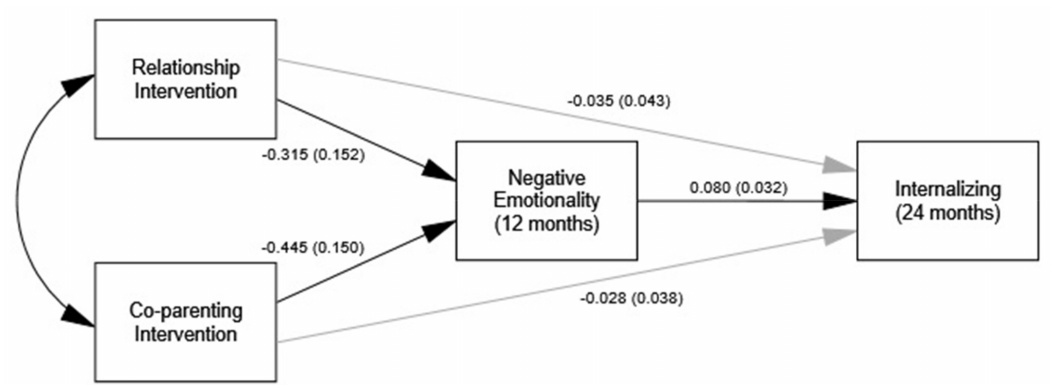
Figure 2. Model estimates (SE) for e ff ects of intervention on reduced externalizing symptoms at 12-months and reduced infant externalizing symptoms at 24-months. Single-headed black arrows represent significant paths. Single-headed gray arrows represent non-significant